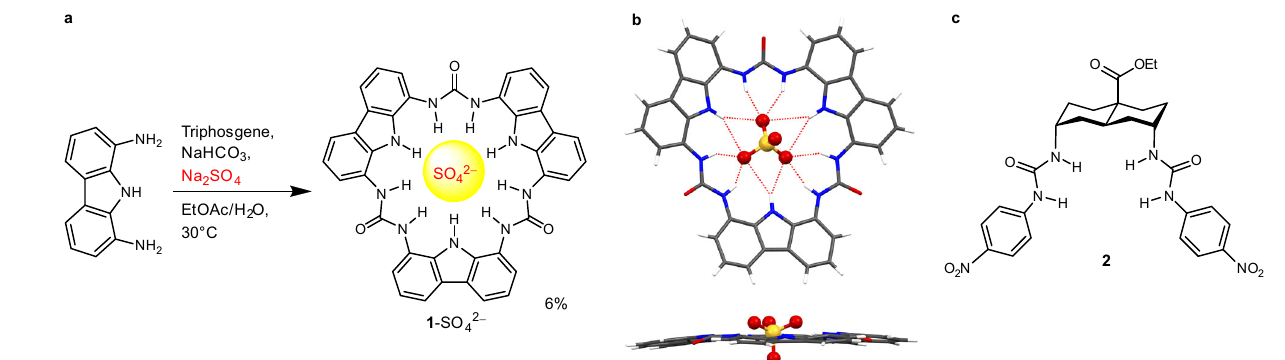
Fig. 1 | Compound structures, synthesis and crystal structure. a Synthesis of macrocycle 1 . The SO 4 2 – template could be removed by EtOAc/H 2 O extraction, which, however,ledto partial degradation of the macrocycle. Thefree macrocycle with 80 – 90% purity wasusedin 1 H NMR titrations in DMSO- d 6 /0.5%H 2 O. The pure SO 4 2 – complex was used in fl uorescence and membrane transport studies in water